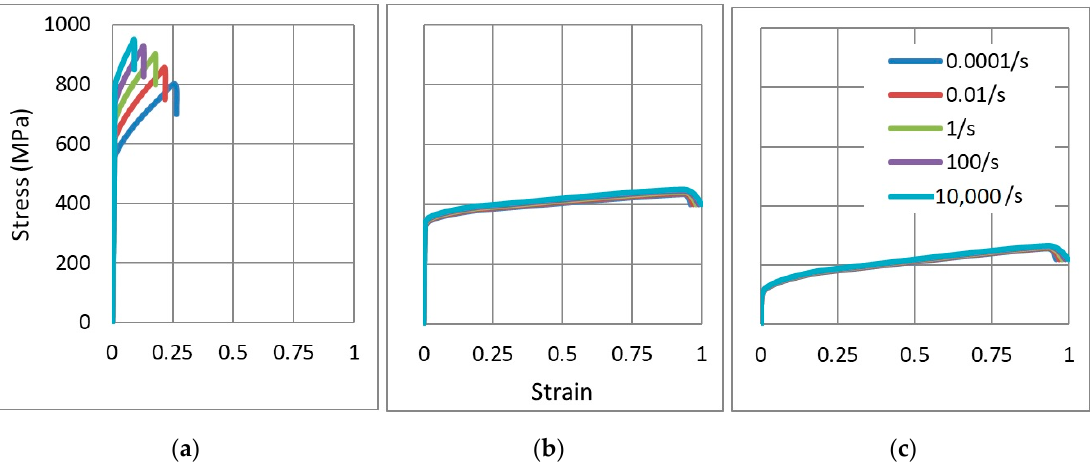
Figure 4. Stress-strain relationship for the three aluminium grades, at different strain rates (y-axis is the same for each subfigure), ( a ) Grade AL7075-T6 (AL1), ( b ) Grade AL6061-T6 (AL2), ( c ) Grade AL6063-T4 (AL3).